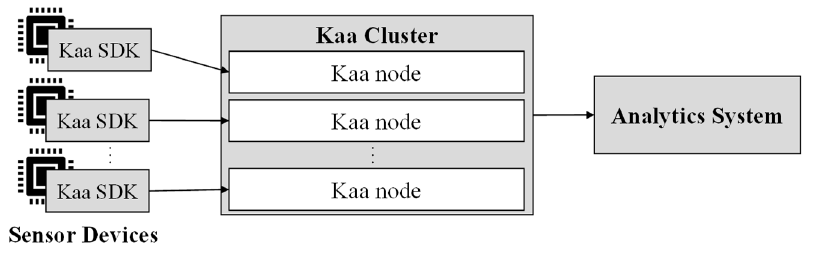
Figure 2. Kaa Internet of things (IoT) platform architecture.